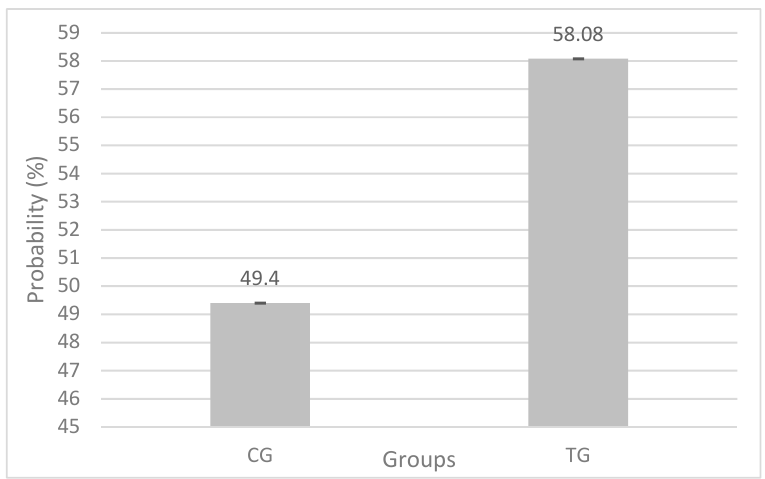
Figure 2. Probability of obtaining a positive pregnancy in the control (CG) and treatment (TG) groups when compared within the YG, according to the statistical model used.